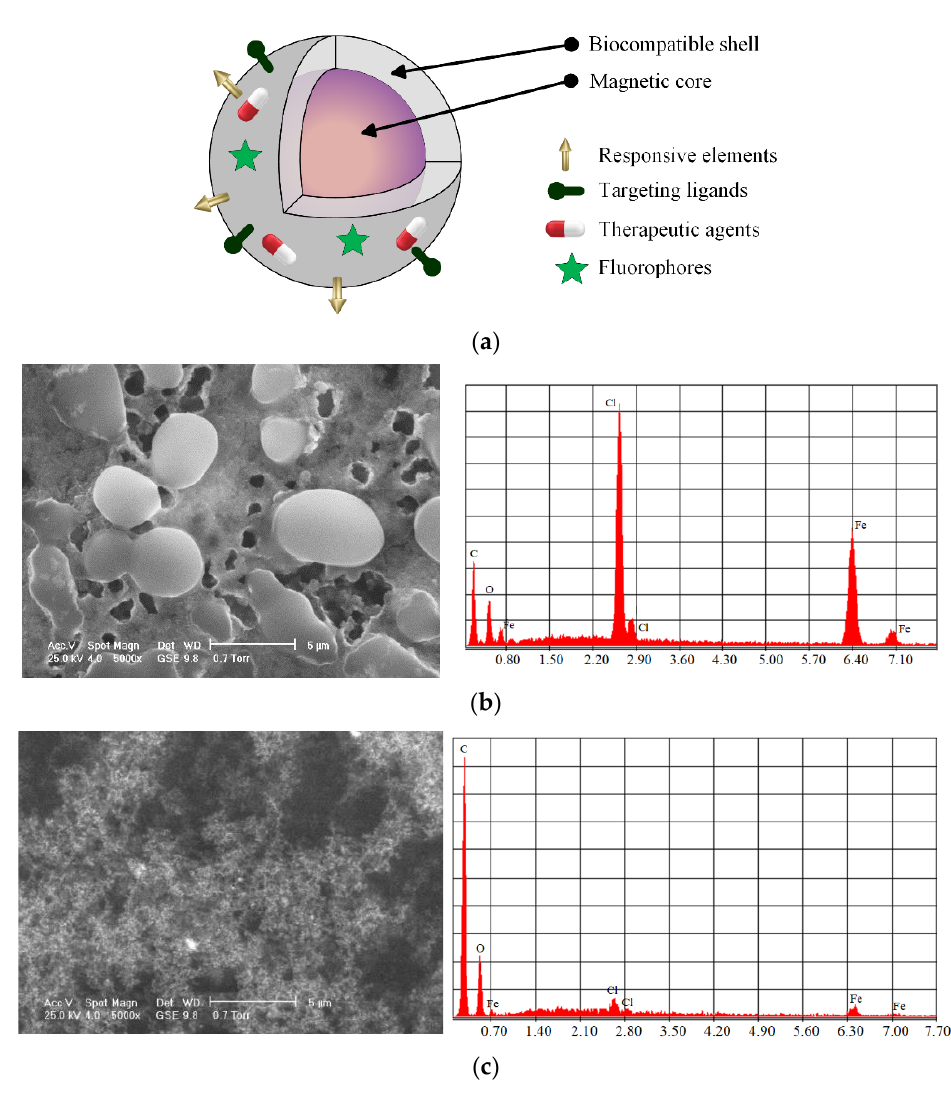
Figure 5. Representation of an MNP, SEM images, and elemental analysis of Fe 3 O 4